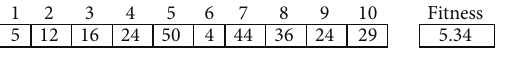
Figure 4: An illustration of a